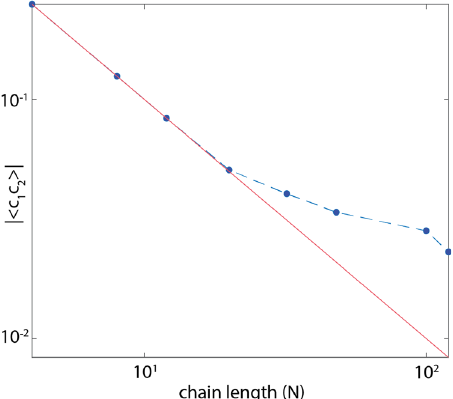
Fig. 3 Observable scaling with the system size. Local observable scaling vs. the chain length N when the initial correlation in all cases is the same as two-site correlation of h ^ c n ^ c m i ¼ 1 þ i and initial occupation of h ^ c y n ^ c n i ¼ 1. The dots are the results of the moments equations of motion integration, the dashed line is guide to the eye, and the red line is N − 1 scaling for